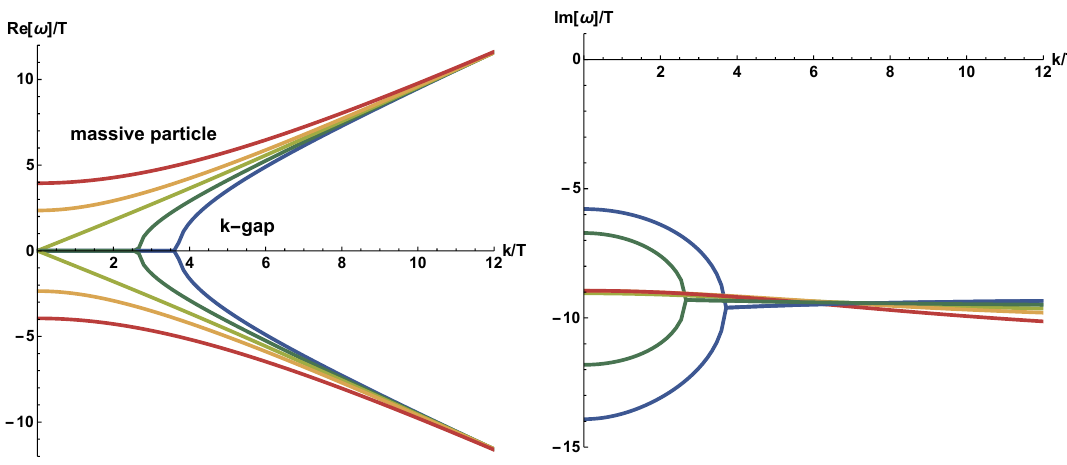
Figure 10 . The shear channel QNMs spectrum for various T=m (from red to blue T=m is increas- ing). The (cid:12)gure is adapted from